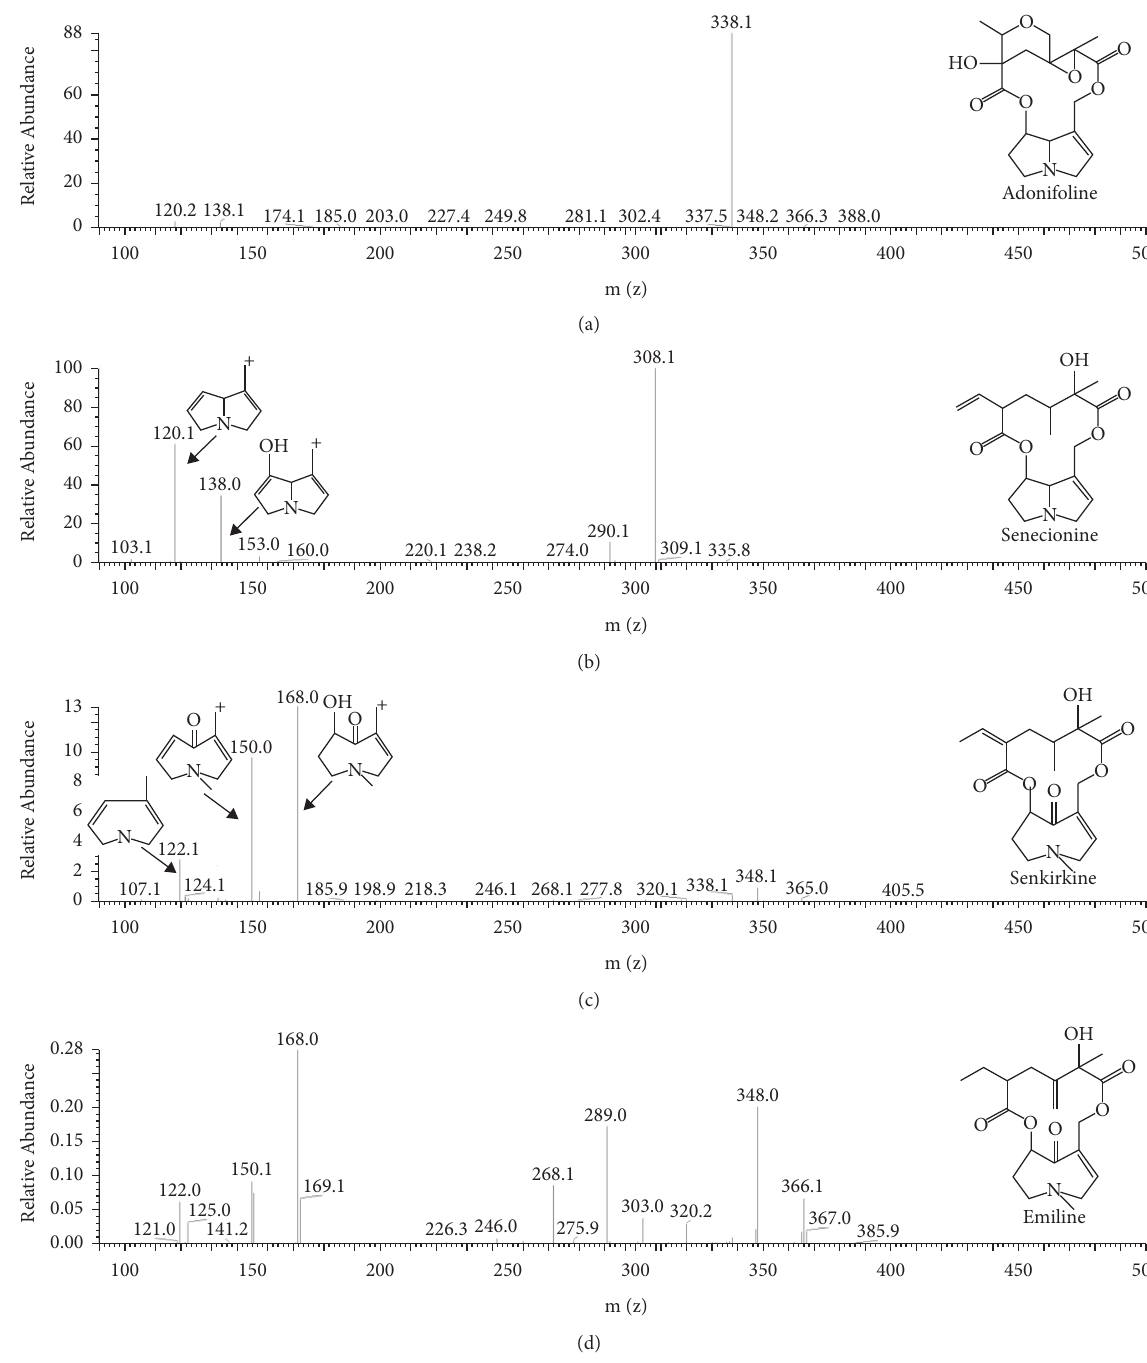
Figure 2: MS/MS spectrum of adonifoline (a), senecionine (b), and senkirkine (c) which were pure standard and PA2 (d) which was presumed as